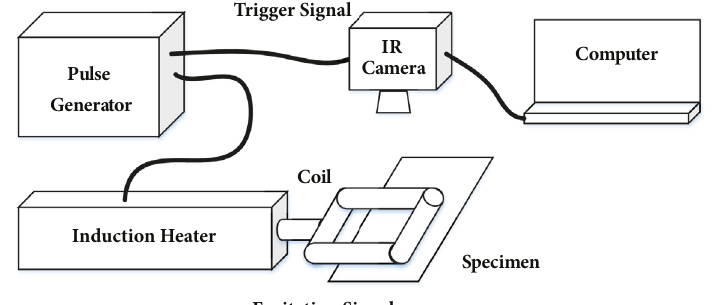
Figure 7: The experimental schematic diagram.